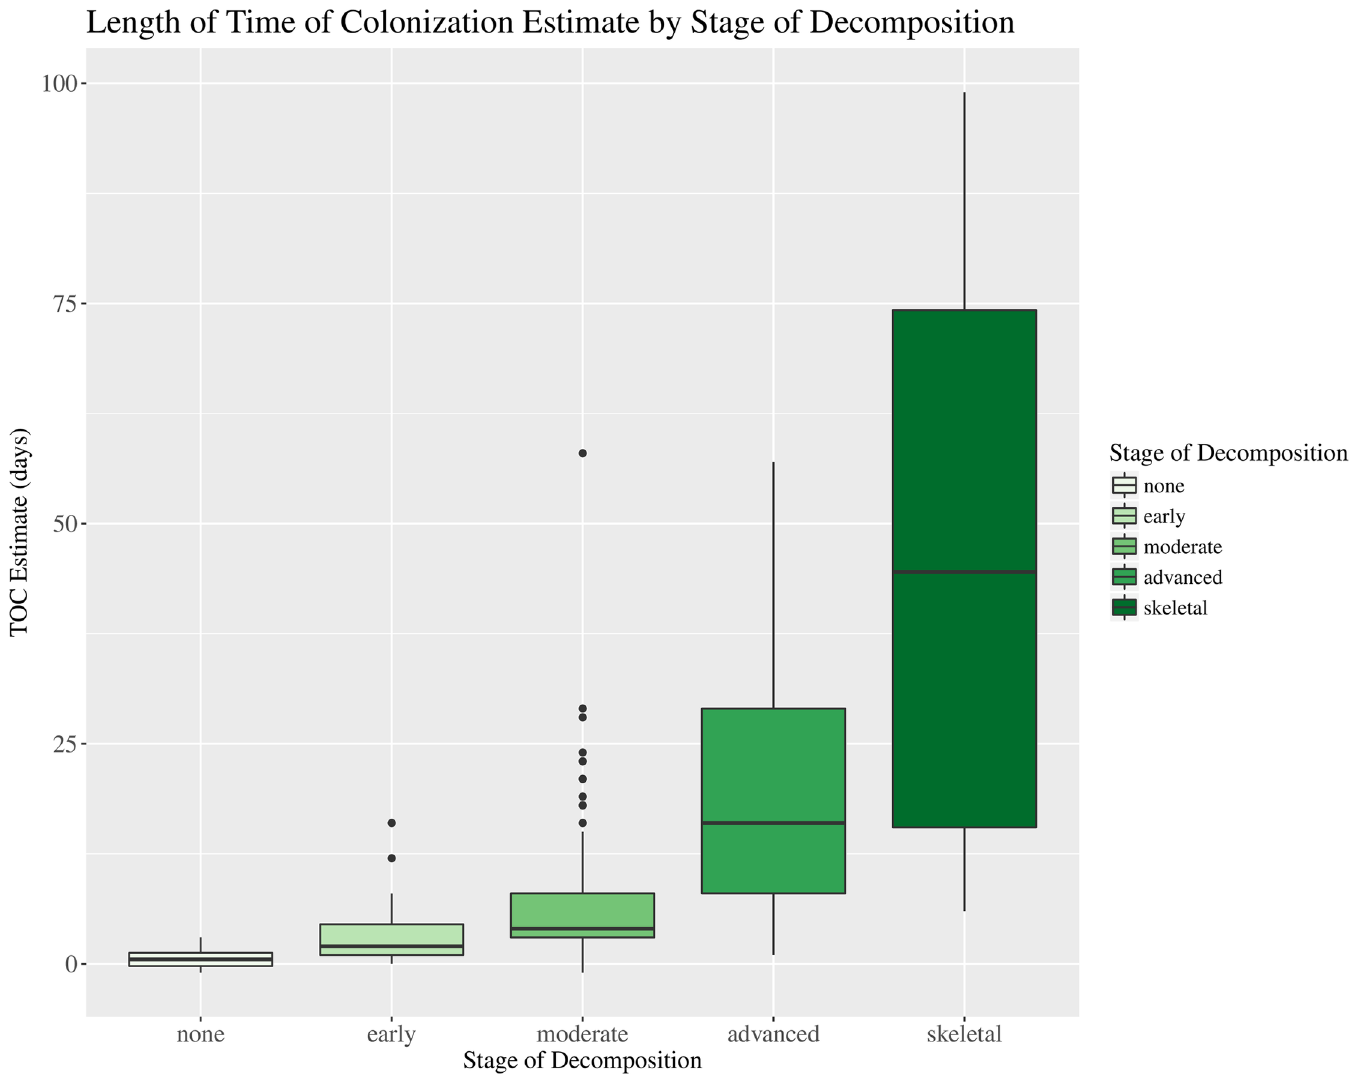
Fig 6. Boxplot of median time of colonization (TOC) estimate(days) by stage of decomposition. Boxplot illustratingthe median time of colonization (TOC) estimate (days) and associated variationfor decedents found in different stages of decomposition for forensic entomology cases over the study period (January 2013–April 2016). (N =